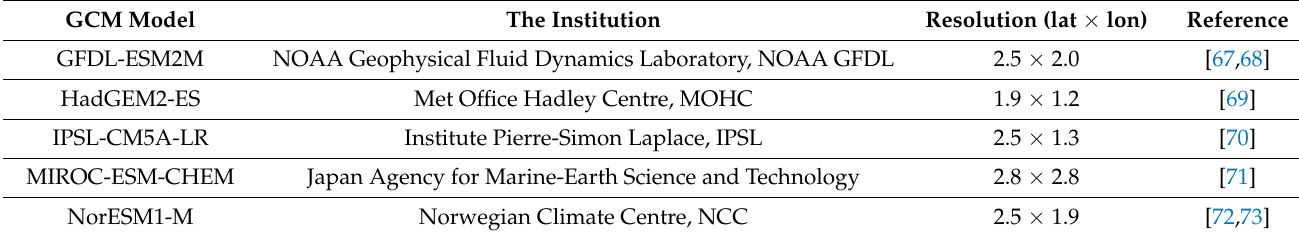
Table 2. The CMIP5 global climate models and their sources.